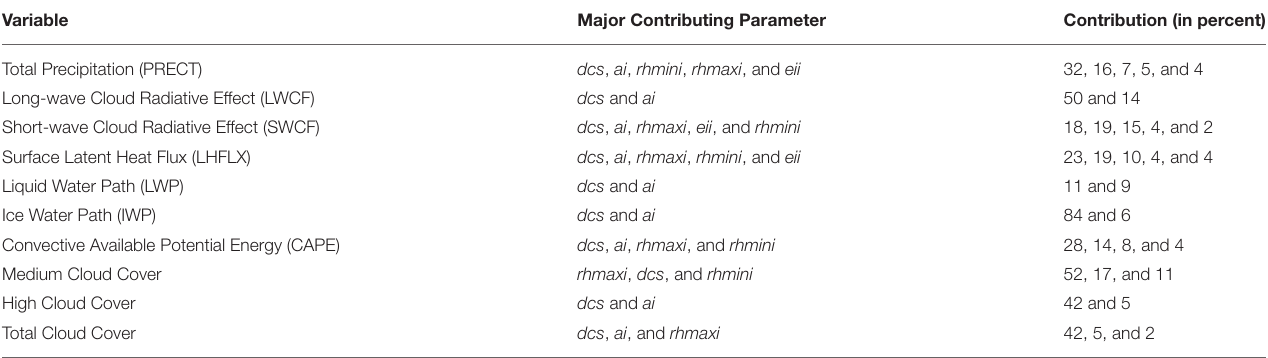
TABLE 2 | First-order sensitivity contribution of parameters for different